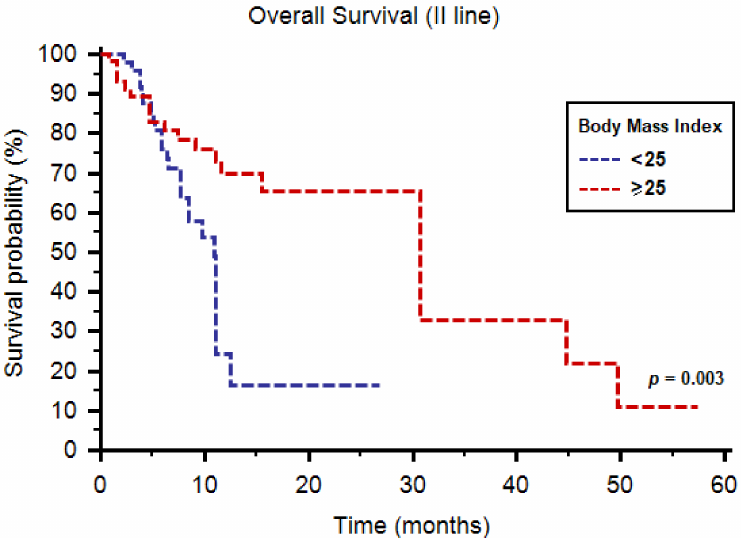
Figure 2. Overall survival of patients receiving cabozantinib as second-line therapy stratified by body mass index.